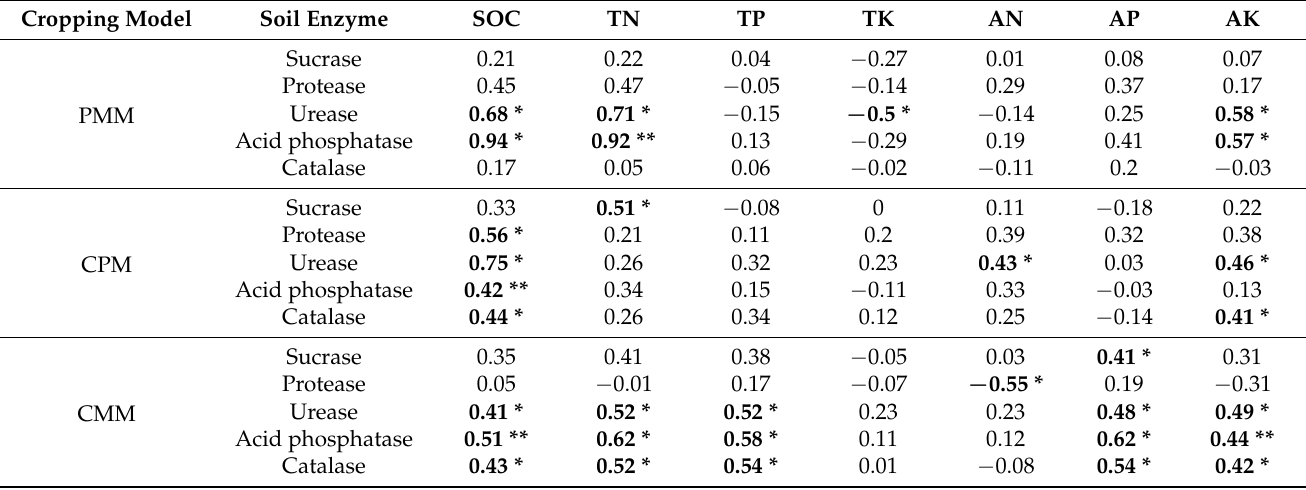
Table 2. Correlation analysis of soil nutrients and enzyme activities in C. oleifera mono-cropping model (CMM), peanut mono-cropping model (PMM), and the Camellia–peanut inter-cropping model (CPM). Cropping Model Soil Enzyme